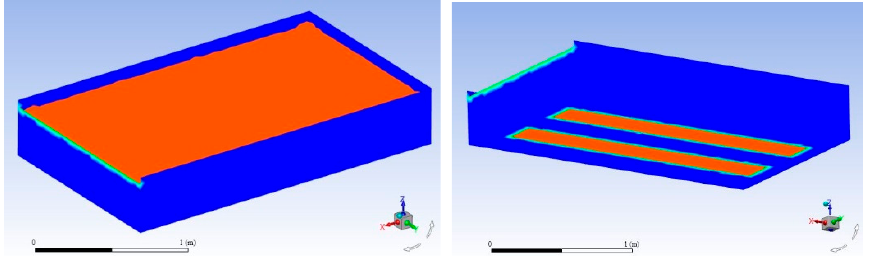
Figure 13. VOF distribution of water and air inside the tank ( left ) and at two values at the tank bottom ( right ) when t = 0.01 s (red indicates water).